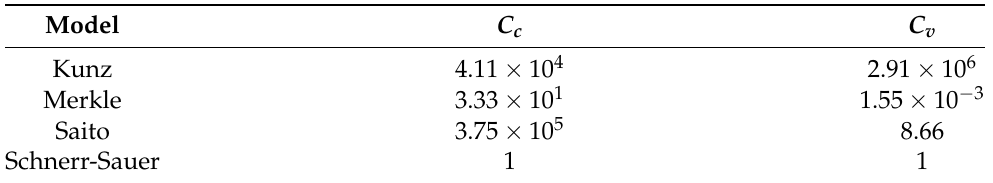
Table 3. Analytical-based coefficients.